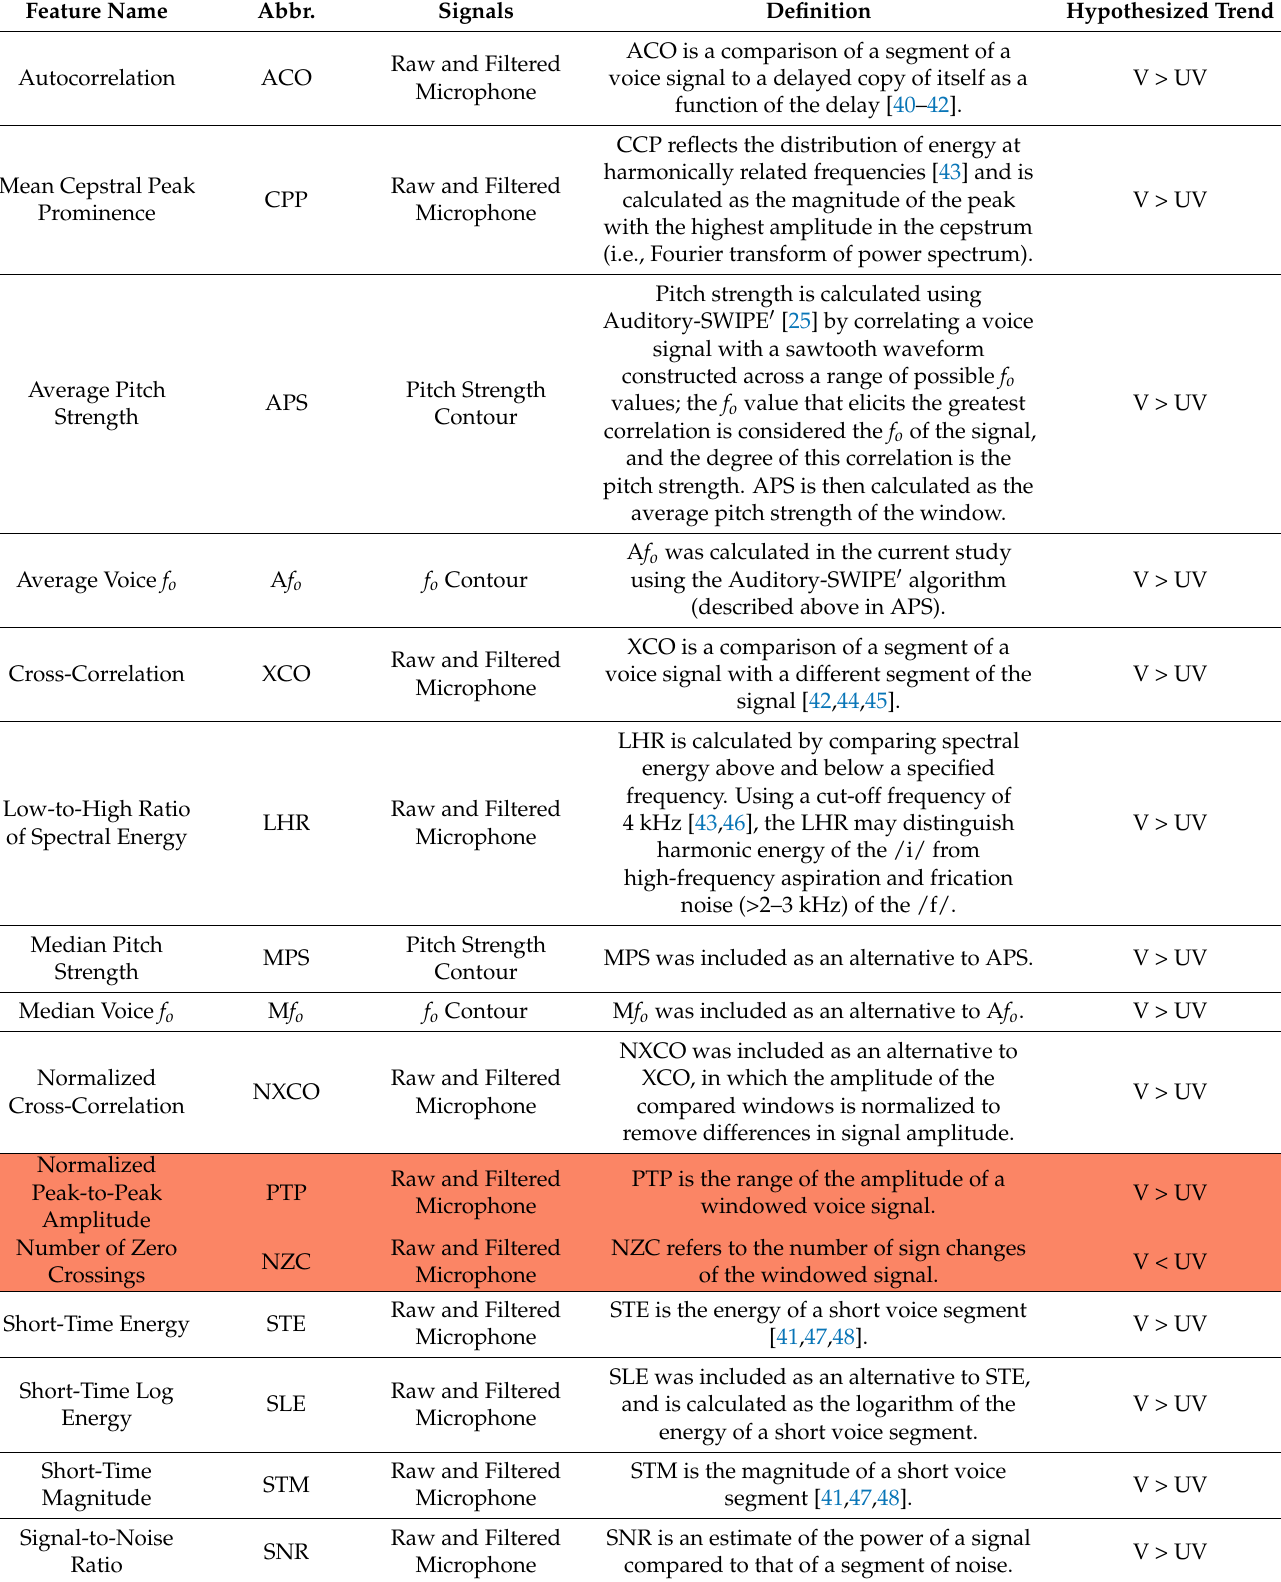
Table 3. Acoustic measures for classifying voiced and unvoiced speech segments, with abbreviations (Abbr), the signal used to calculate the feature, feature definition, and proposed hypotheses surrounding feature trends in voiced (V) vs. unvoiced (UV) segments. Rows that are shaded orange indicate that the acoustic feature was included in aRFF-AP